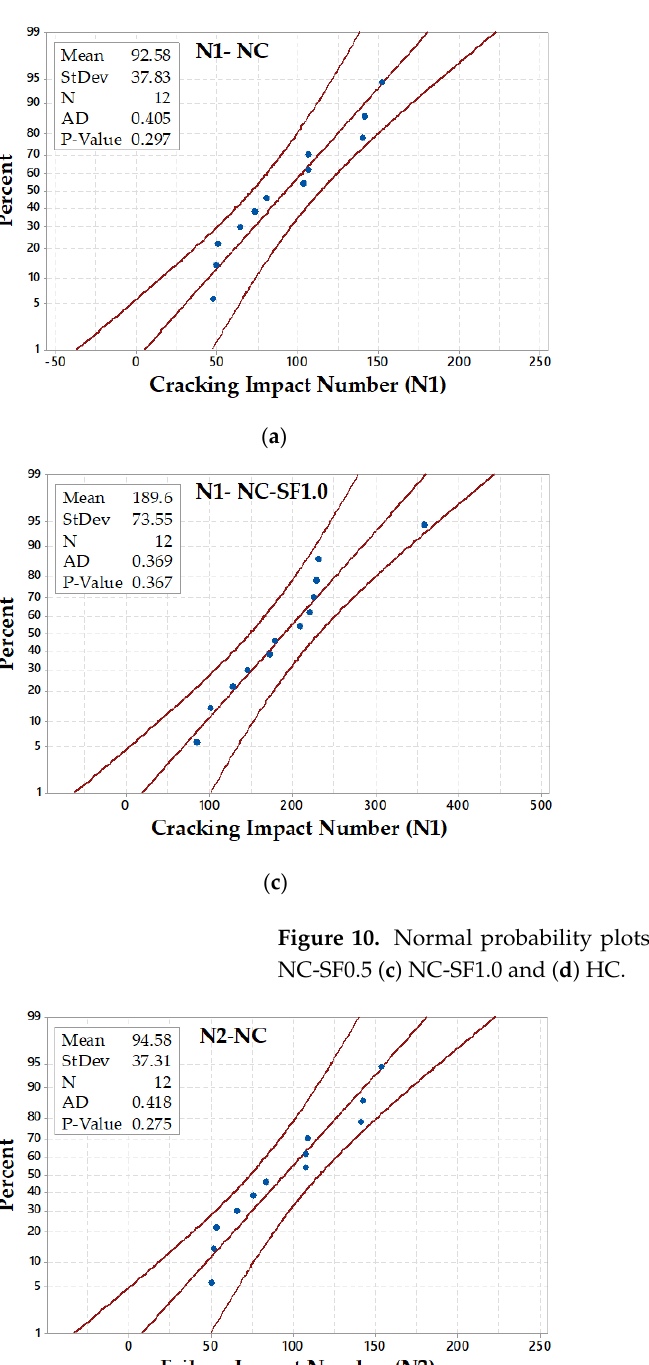
Figure 9. Distribution of results at the failure stage for mixtures ( a ) NC ( b ) NC-SF0.5 ( c ) NC-SF1.0 and ( d ) HC.